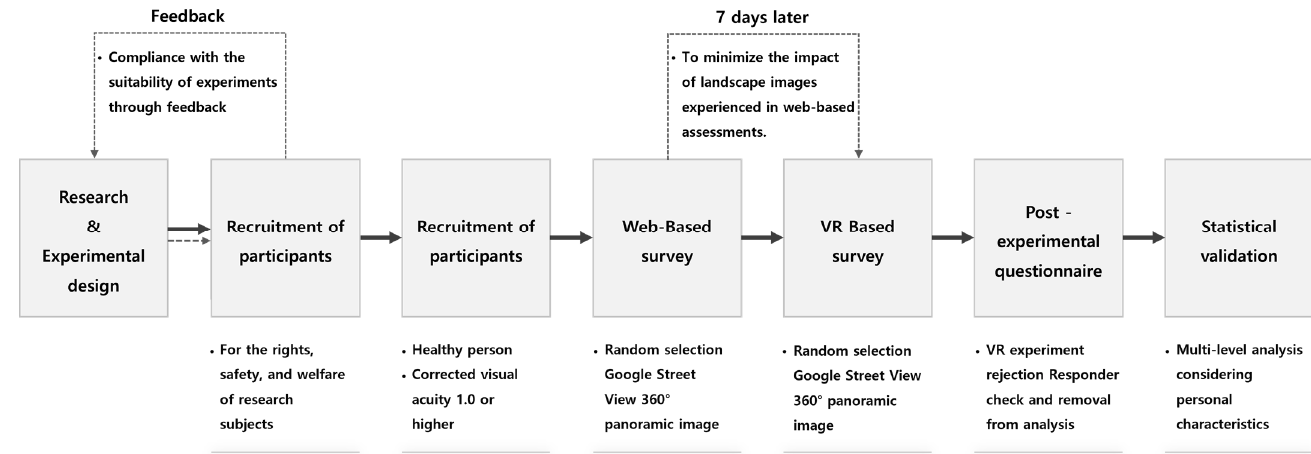
Figure 1. Research